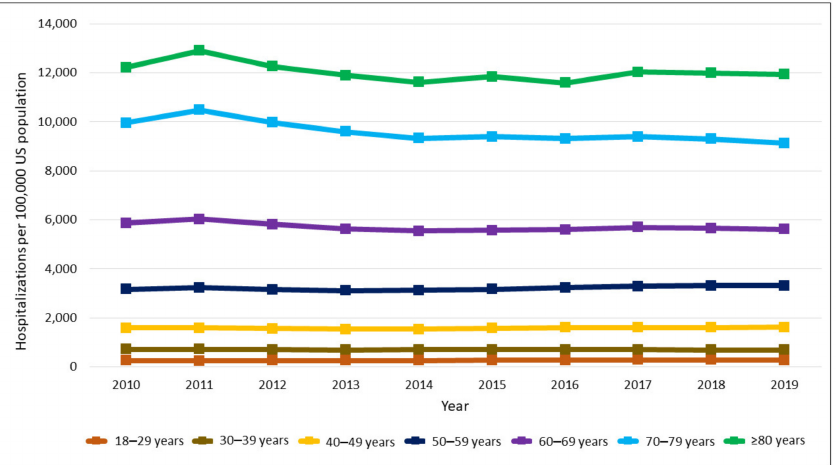
Figure 2. Trends in age-specific population-adjusted diabetes associated hospitalizations.